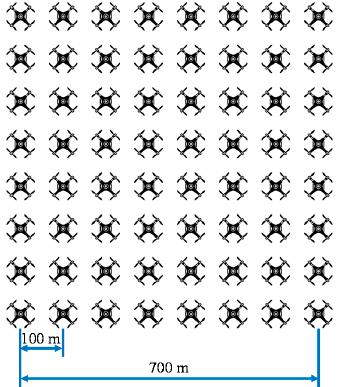
Figure 4. Flying Ad-hoc NETwork (FANET) topology used in the use case.